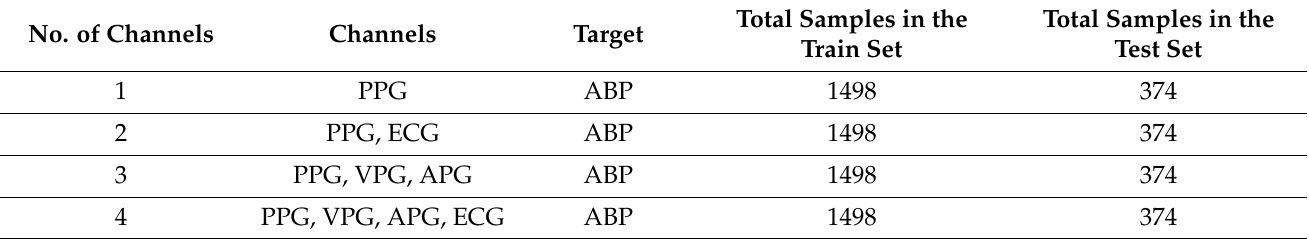
Table 4. Description of training and testing sets for Experiment 2 (Method